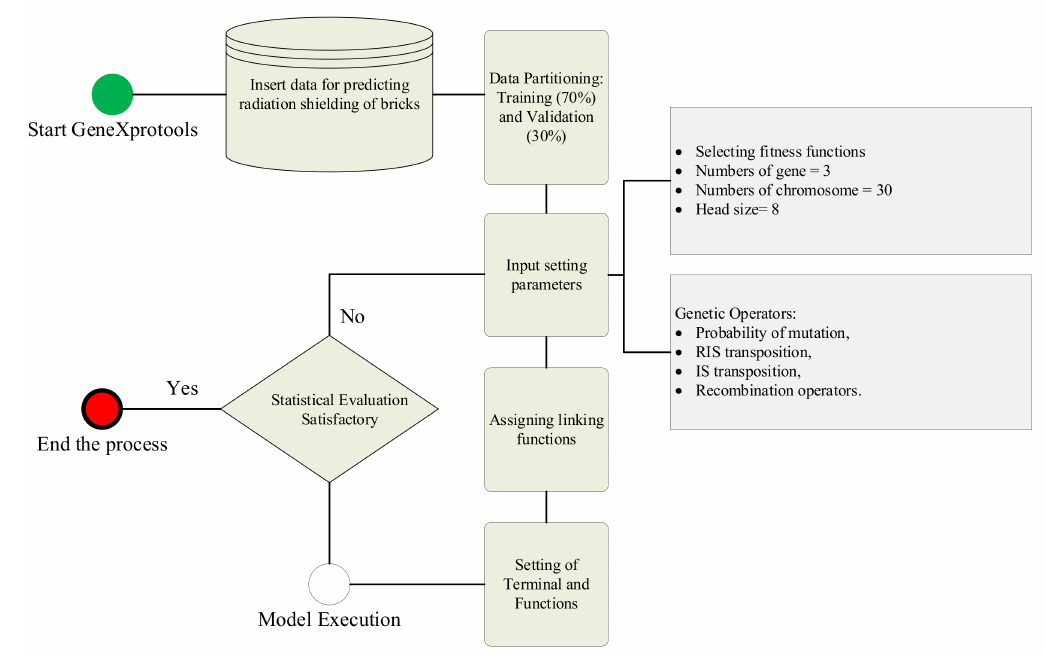
Figure 5. Schematics of GEP